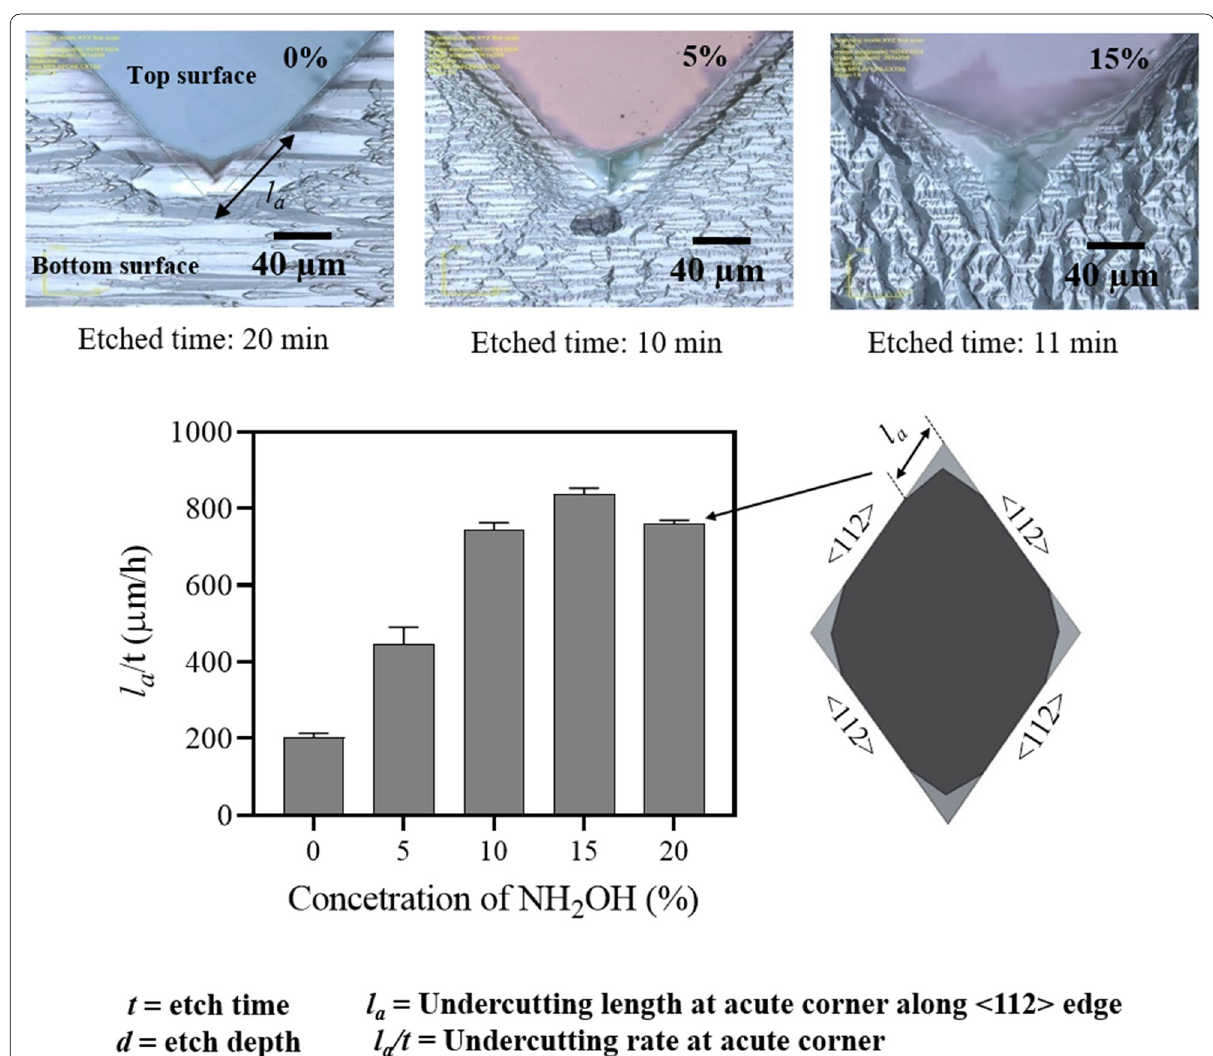
Fig. 58 Undercutting at acute corners on Si{110} surface in pure and different concentrations of NH 2 OH-added 20 wt% KOH at 75